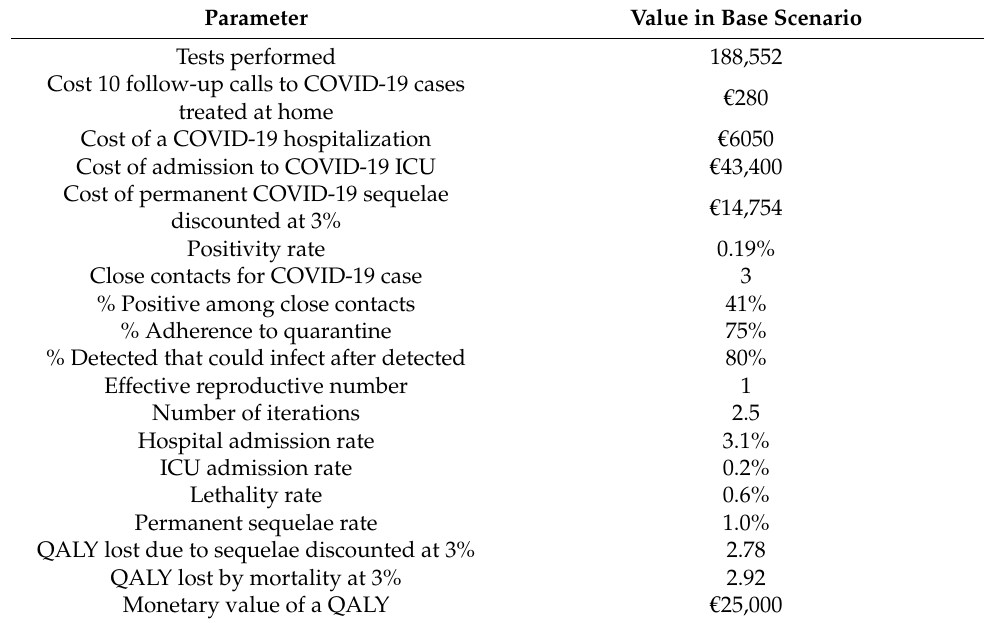
Table 1. Base scenario settings (all